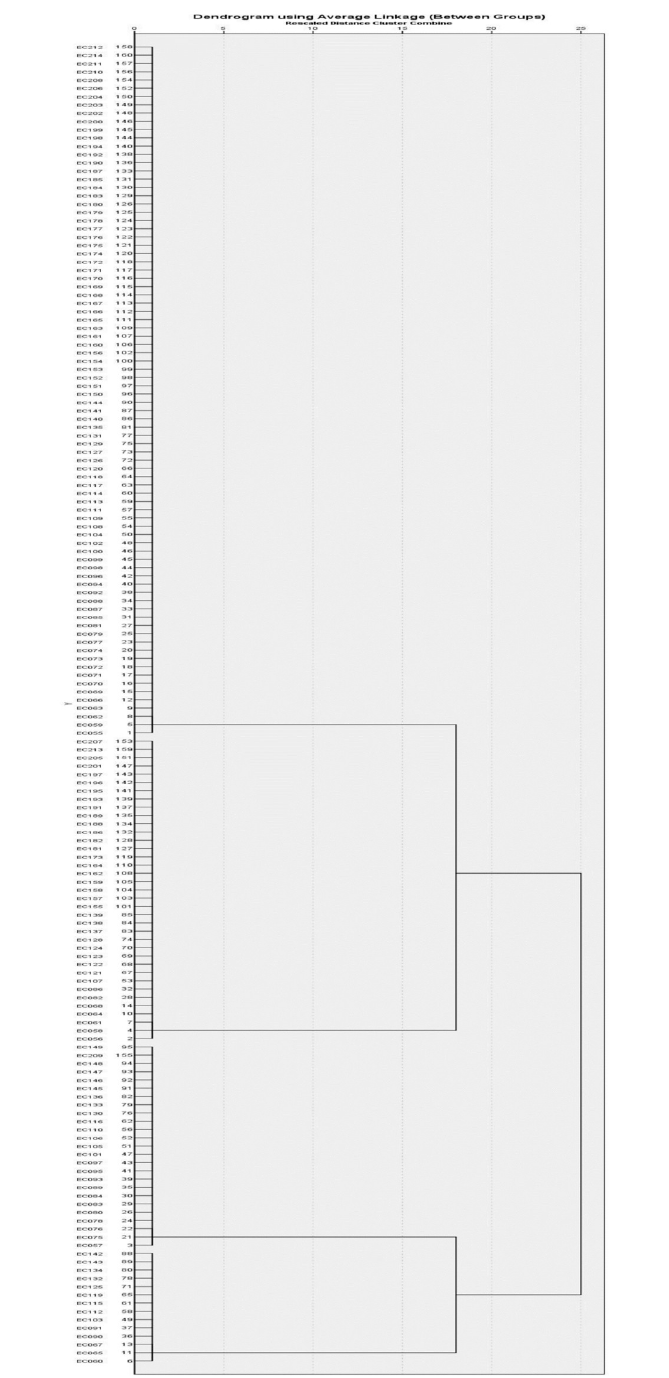
Fig 2. Hierarchical clustering of E . coli isolates according to the presence of iron uptake functional virulence genes ( iroN and fyuA ).